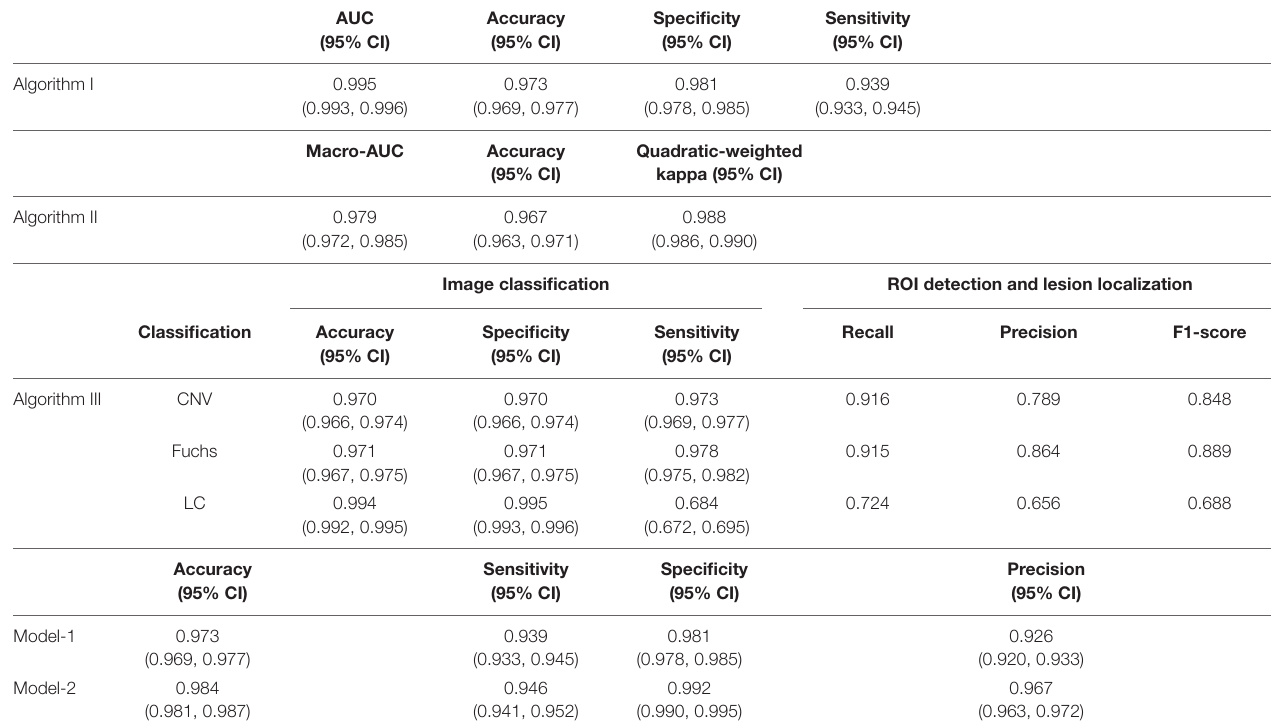
TABLE 2 | Five-fold cross-validation of the performance of the algorithms in the total